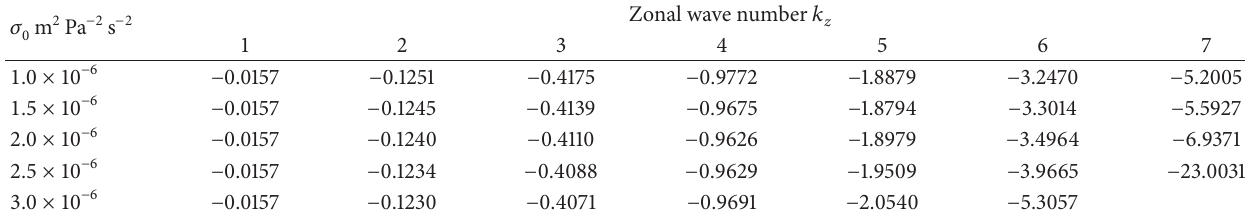
Table 1: Absolute sensitivity 𝑆 𝜎 as a function of zonal wavenumber 𝑘 𝑧 for different values of static stability parameter 𝜎 0 .